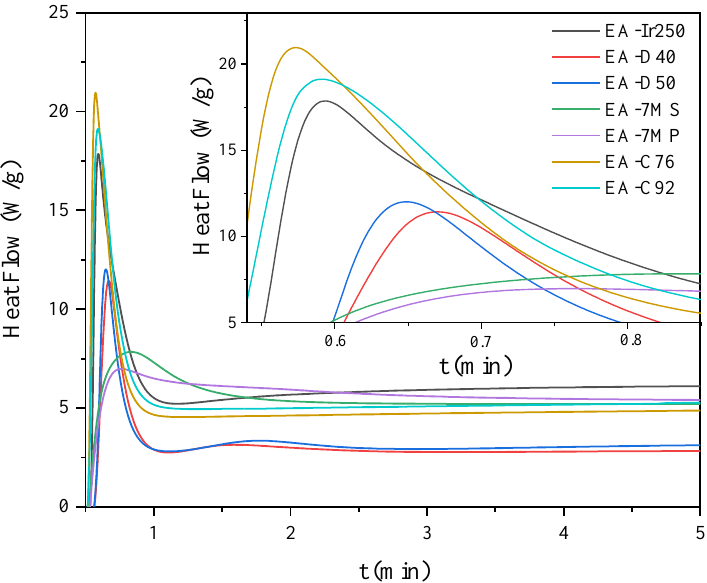
Figure 10. Photo-DSC exotherms for the photopolymerization of epoxy acrylate formulations with cationic photoinitiators.